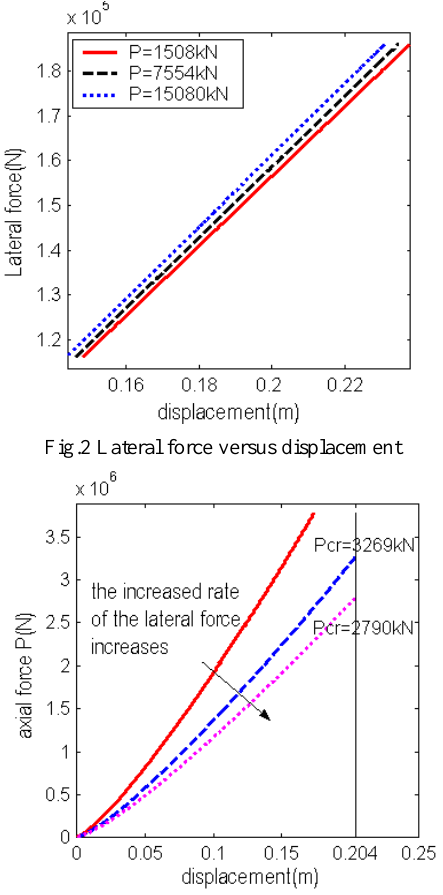
Fig.3 Axial force versus displacement